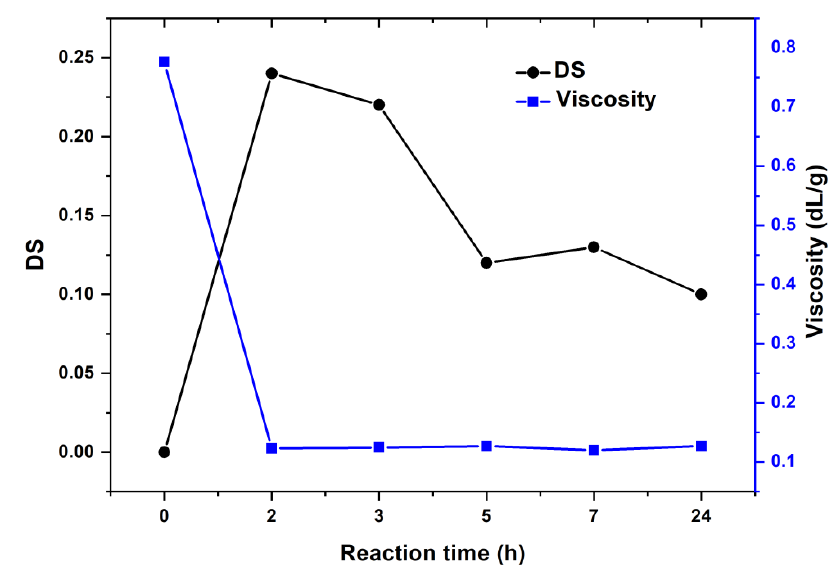
Figure 5. Effect of the intrinsic viscosity on the degree of substitution (DS).